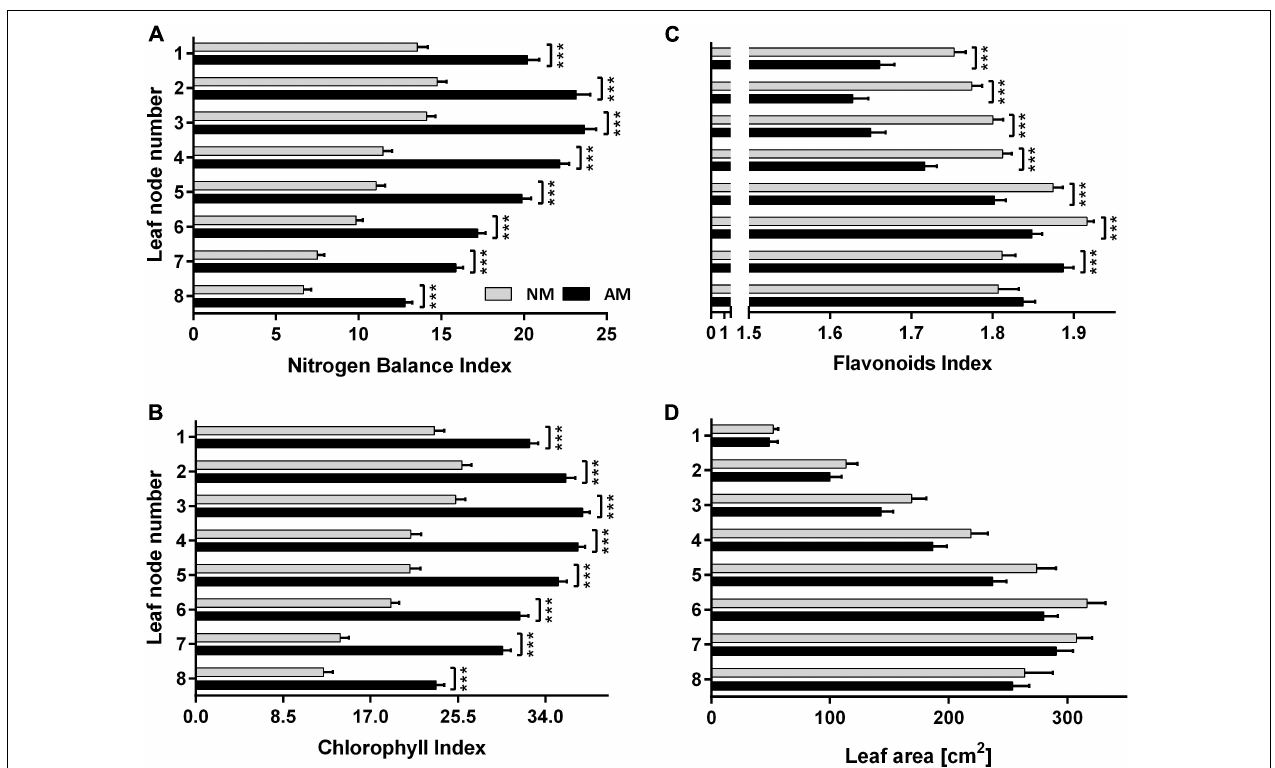
FIGURE 6 | Leaf nitrogen status (A) , chlorophyll (B) and flavonoids (C) level and leaf area (D) at 8 leaf positions after 2-week drought imposed at silking time (10 weeks after sowing, fertilized with 1xD dose) and 7 days of rehydratation. The error bars show the standard error of the mean ( n = 60 for NBI, Chl and Flv: 6 plants × 10 sampling points covering upper half of leaf length, n = 6 for leaf area measurements). Asterisks show statistically significant difference between NM and AM means according to t -Student test ( ∗ p < 0.05, ∗∗ p < 0.01, ∗∗∗ p <